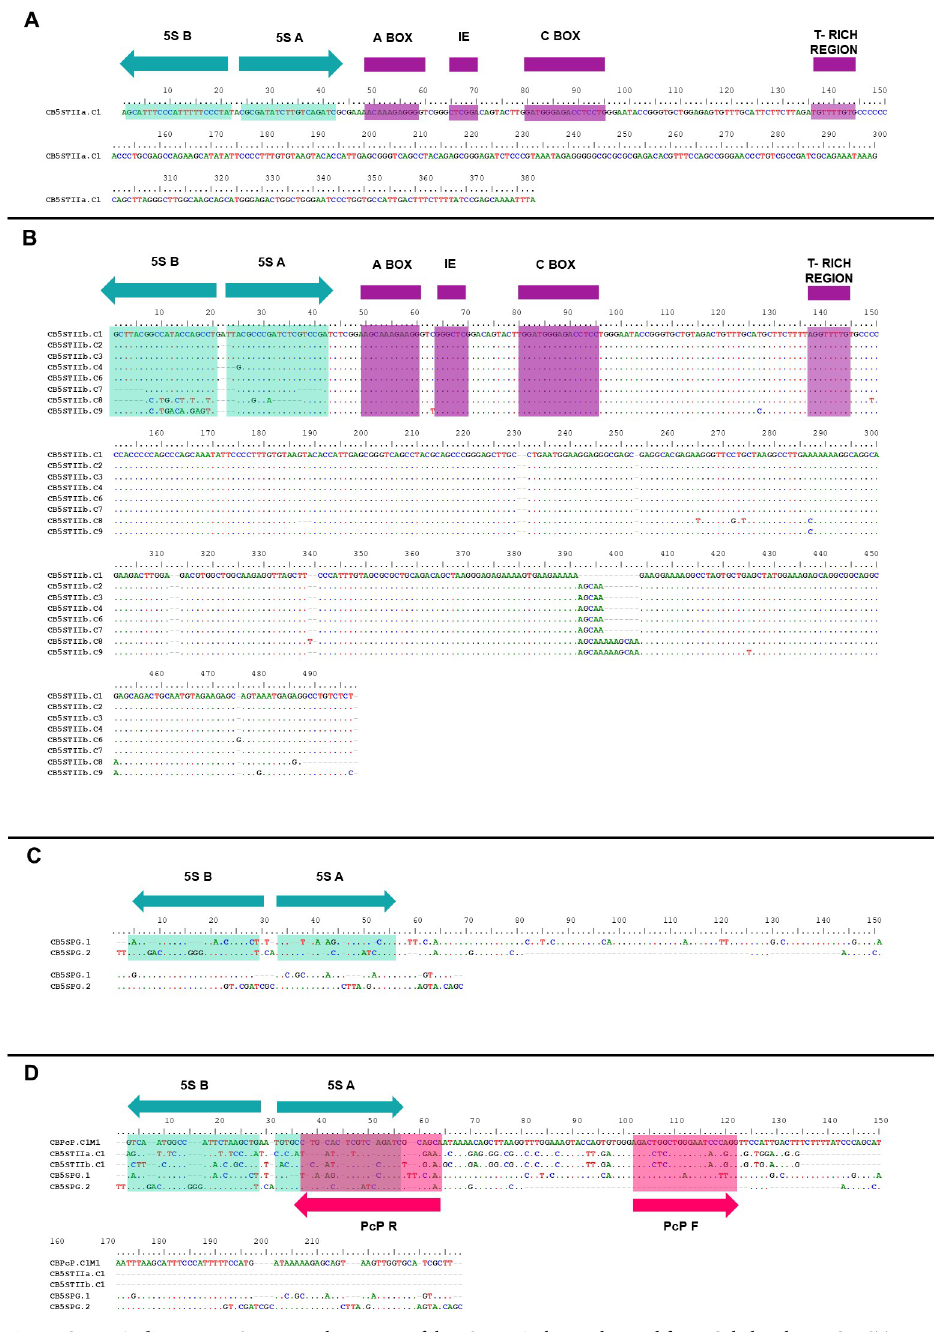
Fig 2. 5S rDNA alignments. Sequence alignments of the 5S rDNA clones obtained from C . bolitoglossus CB5STII.a ( A ), CB5STII.b ( B ), and CB5SPG ( C) . In D , CB5SPG is aligned with CB5STII.a, CB5STII.b, and the PcP190 satDNA. The primer annealing sites of 5S-A are highlighted as blue arrows whereas the PcP190 satDNA primer sites are highlighted as green arrows. The internal control regions of the 5S rDNA gene are shaded in purple in A and B .